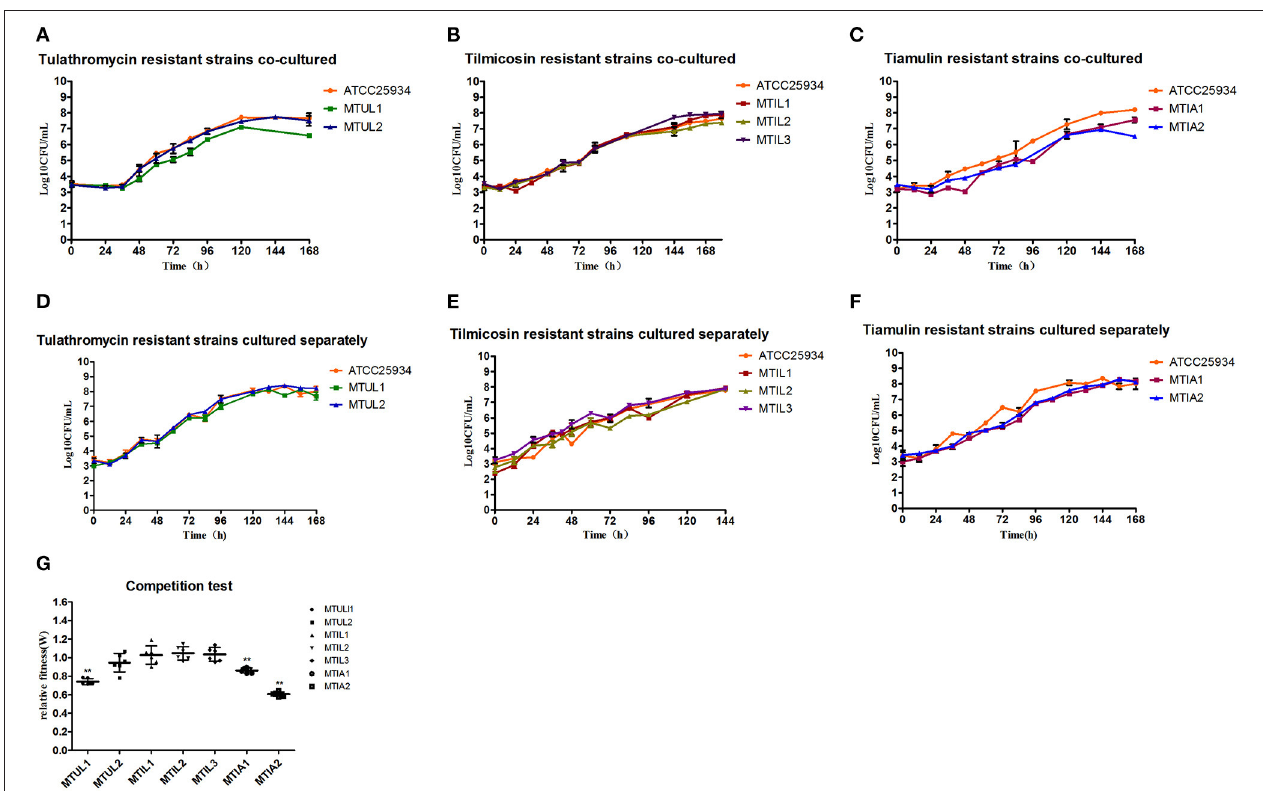
FIGURE 4 | Fitness cost analysis of 23S rRNA mutants. (A–C) Growth curve of drug-resistant mutants and parental strains in co-culture. (D–F) Growth of drug-resistant mutants and parental strain cultured separately. (G) Relative fitness of all 7 mutants. Error bars show standard deviations. ** P <